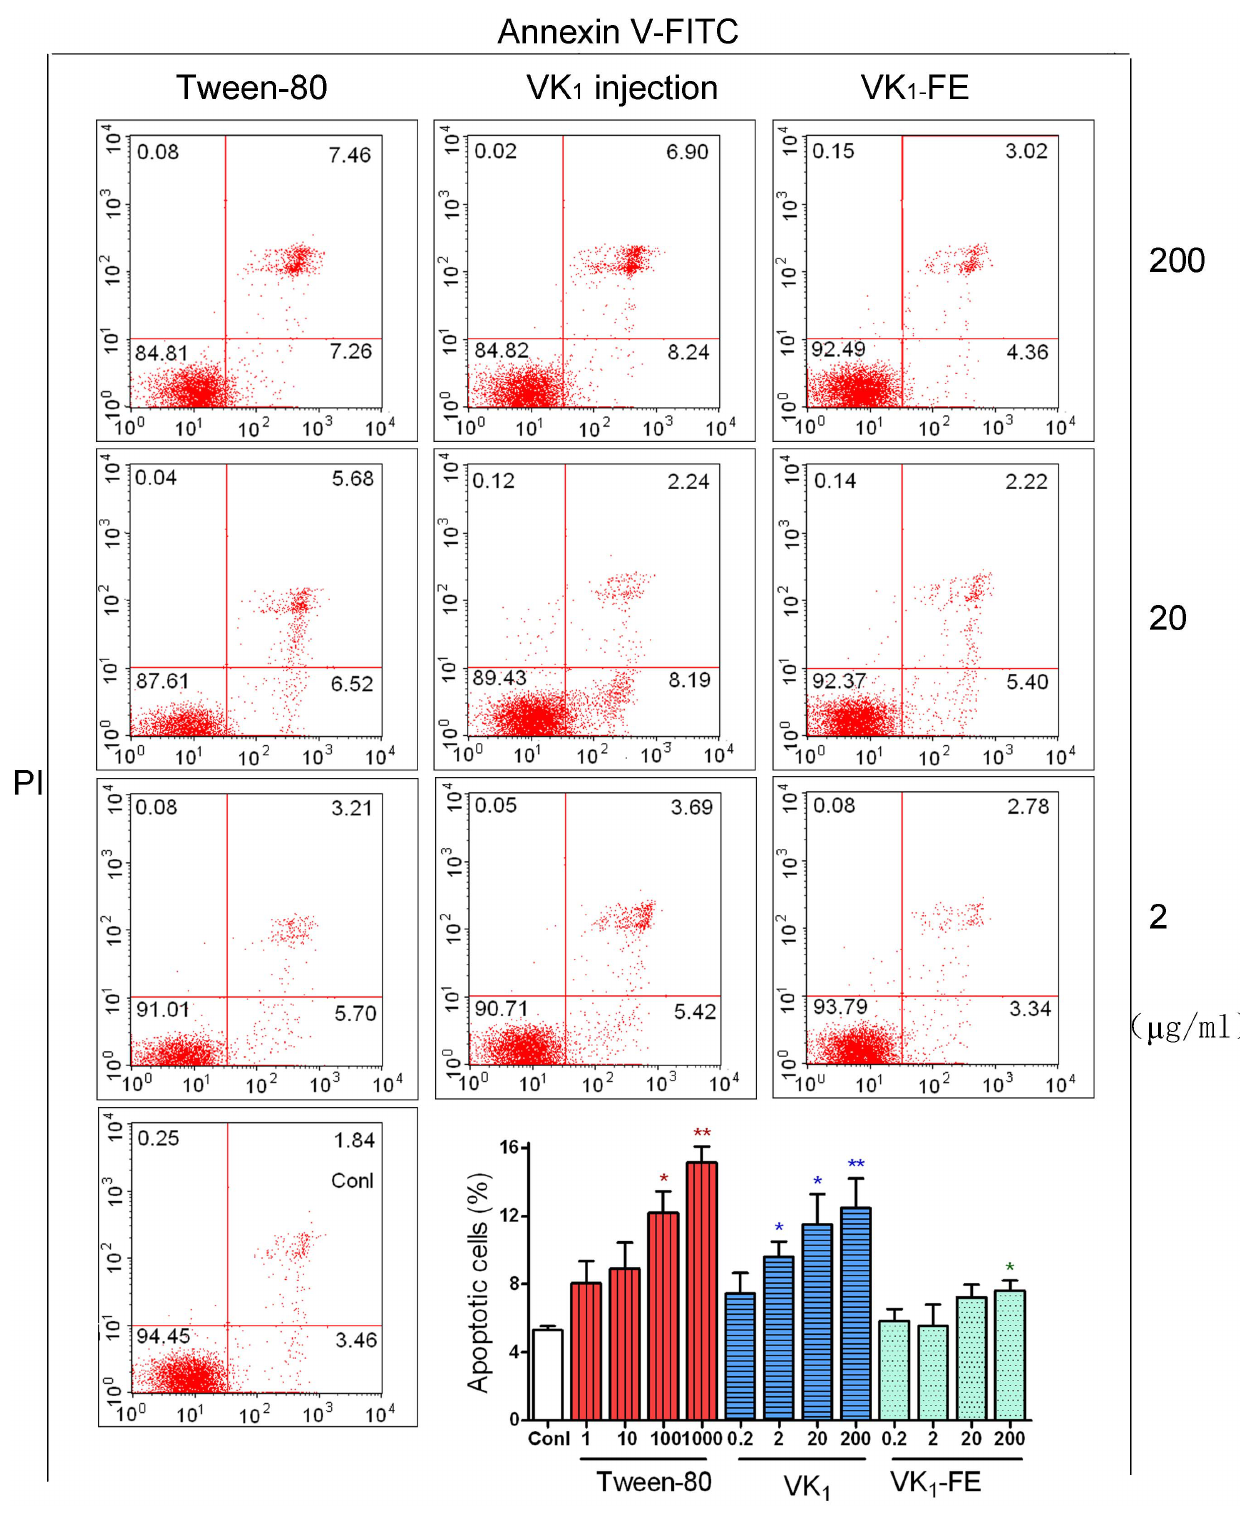
Figure 5. Effect of vitamin K 1 (VK 1 ) injection on the apoptosis of RBL-2H3 cells by flow cytometry. Apoptotic cells were identified by Annexin V-FITC and PI staining. The concentrations of Tween-80 are 1000, 100, and 10 m g/mL, from top to bottom. The values are shown as the mean 6 SE, n=6. * P , 0.05, ** P , 0.01 vs. control (conl). VK 1 -FE: vitamin K 1 -fat emulsion.